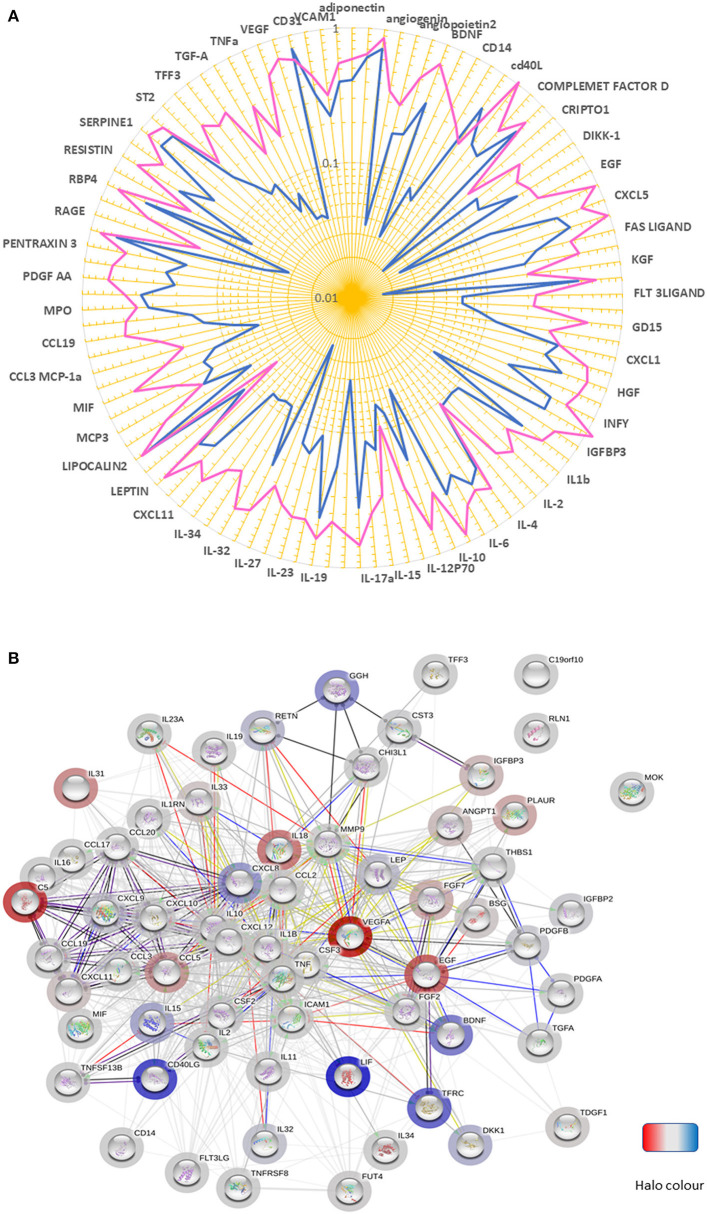
Altered chemokine profile in BM of patients with T2D. (A) Spider graph showing the expression levels of chemokines, cytokines, and proteins measured using a proteome profiling array in bone marrow perfusates of three subjects per group. Pink line (T2D) and the blue line (ND). (B) The network of factors found to be differentially regulated between T2D and ND. The bar halo color is based on the rank of the protein in the set of input values. Action types are shown as: .